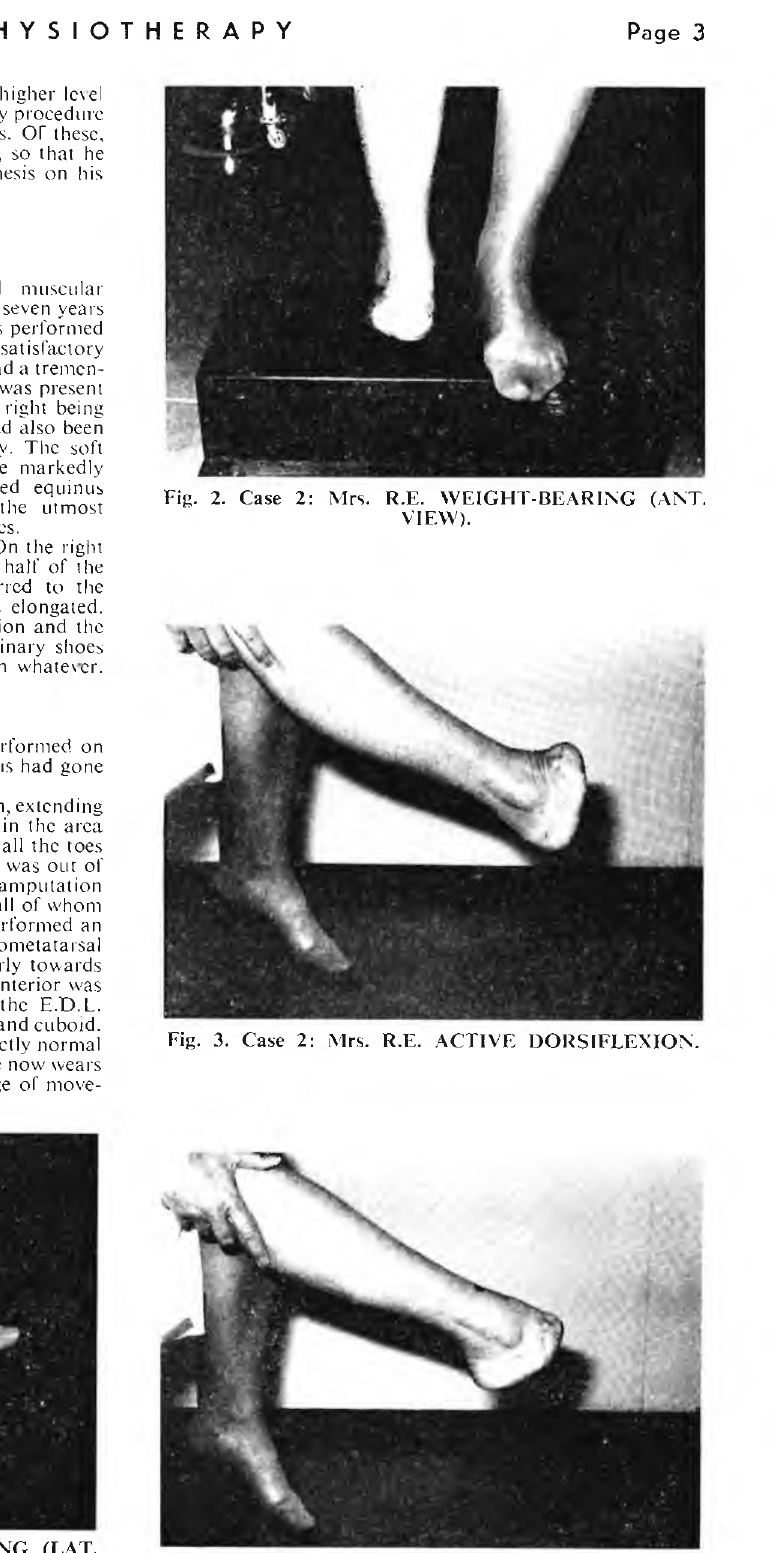
Fig. 1. Case 2: Mrs. R.E. WEIGHT-BEARING (LAT. VIEW). Note slight obliquity of stump, being longer dorsally. Fig. 4. Case 2: Mrs. R.E. ACTIVE